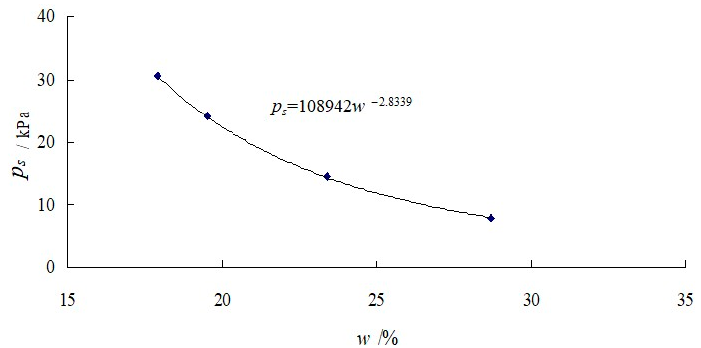
Figure 6. Relation between the equivalent expansive force and initial water content.